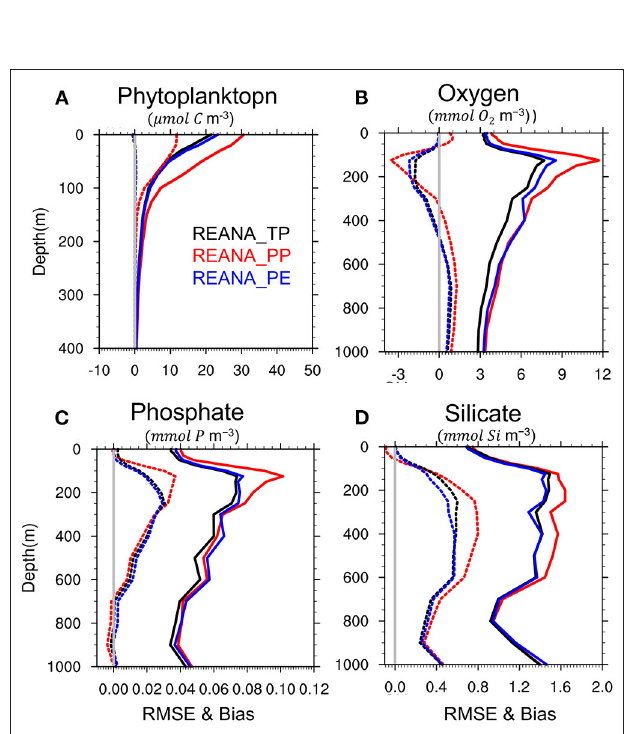
FIGURE 13 | (A) is the globally averaged RMSE (solid lines) and bias (dotted lines) profiles estimated over the 18-months reanalysis period (July 1990- December 1991) for phytoplankton concentration generated using TP (black), PP (red), fixed PE (blue), and assimilating time-varying observations. (B–D) are same as (A) but for oxygen, phosphate, and silicate,